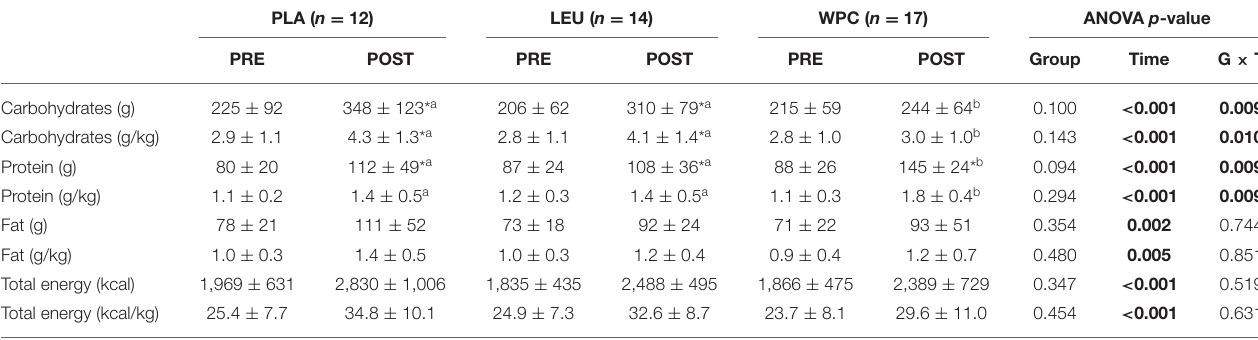
TABLE 3 | Nutrition information prior to and following resistance training.